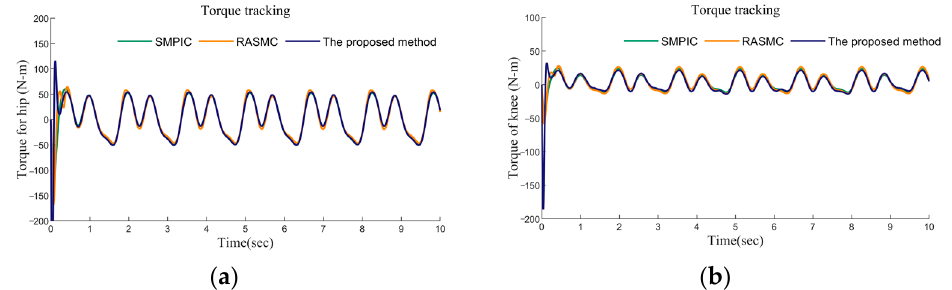
Figure 11. The time history of the joints. ( a ) The time history of hip torque under case 1 condition and ( b ) The time history of knee torque under case 1 condition.